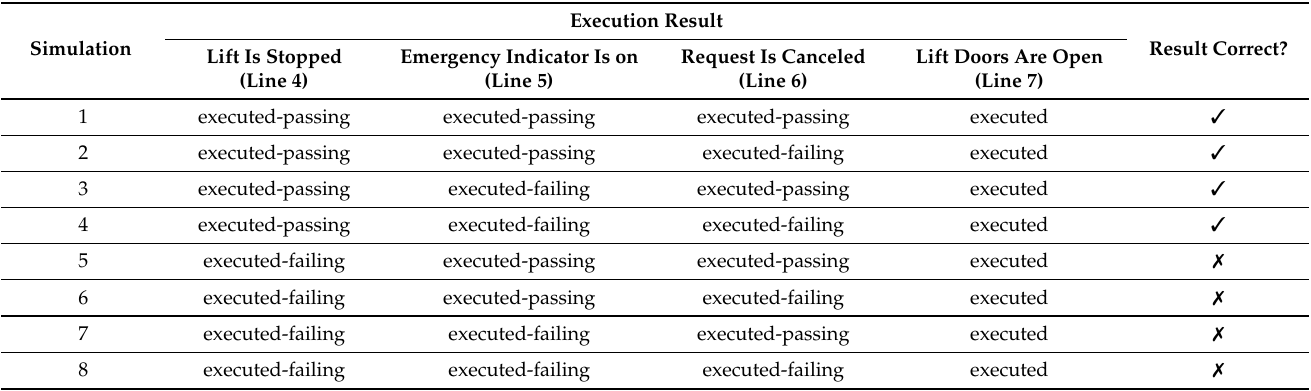
Table 5. Simulation results of executing the lift safety specification in Figure 3: behave without failing-fast.